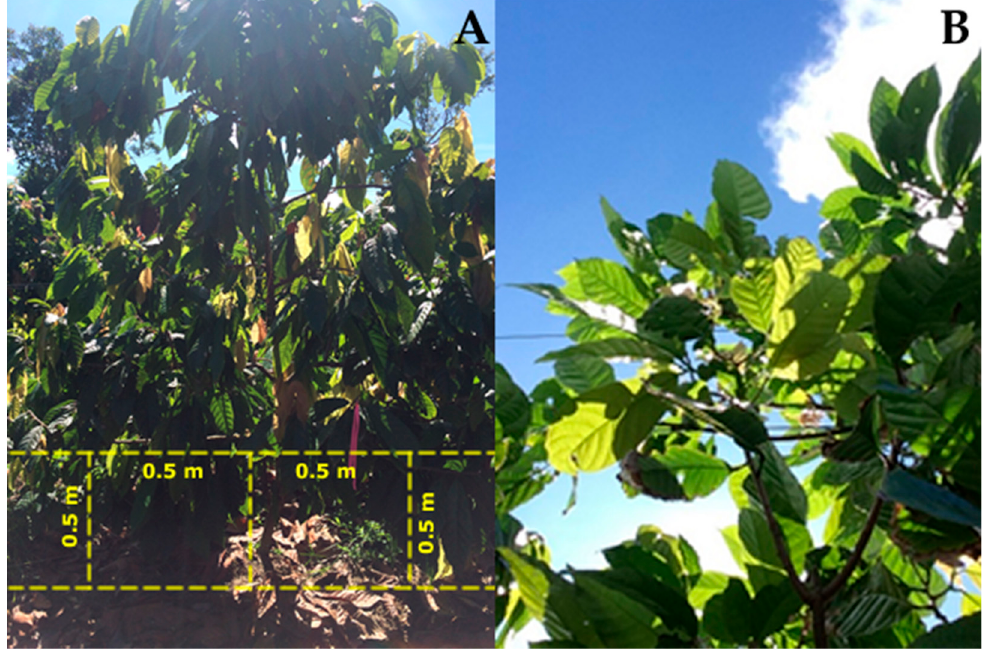
Figure 2. ( A ) Distance of image acquisition data in cocoa trees under a Tatura trellis system using the VitiCanopy application (app), and ( B ) image of canopy recorded using the VitiCanopy app .